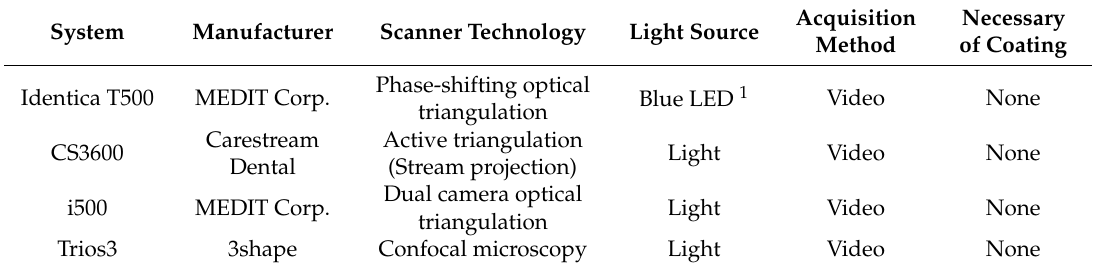
Table 1. Characteristics of scanners used in this study.